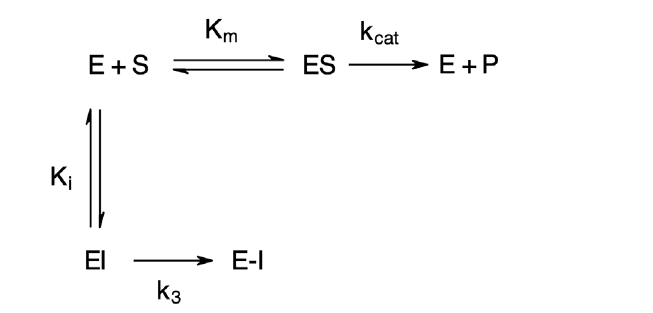
TABLE 1 Kinetic constants for the inhibition of NE, chymotrypsin, and trypsin, by various ABPs. Protease Inhibitor